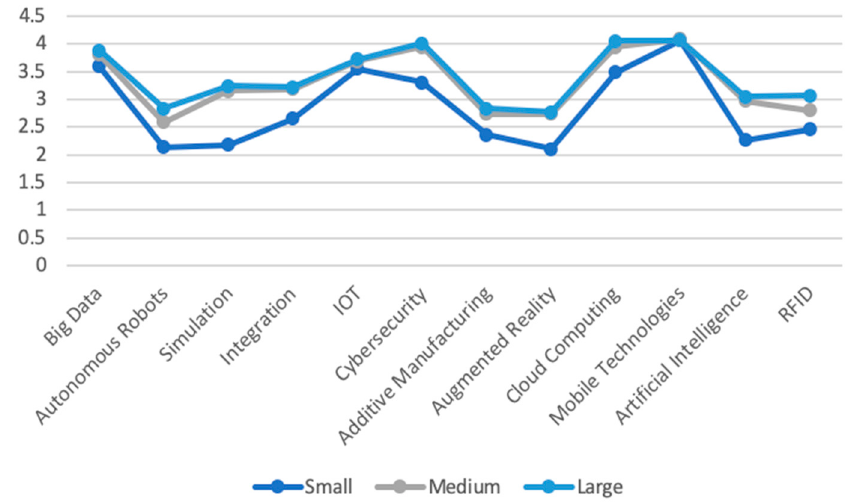
Figure 7. Industry 4.0 technologies (line chart).